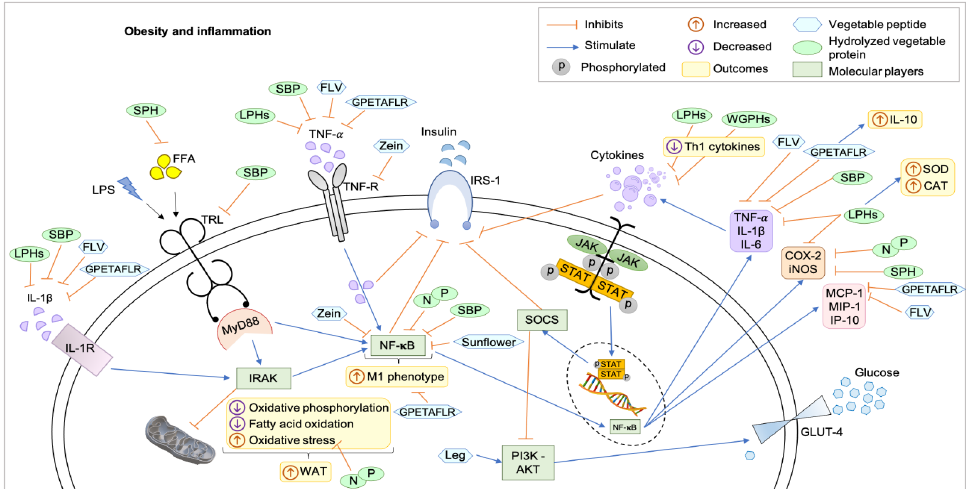
Figure 1. Mechanisms of action of hydrolyzed proteins and plant peptides on obesity and inflammation in a hypothetical eukaryotic cell. All hydrolyzed proteins and peptides acted to reduce inflammation through metabolic pathways that communicate and are responsible for the positive feedback cascade for the accumulation of more adipose tissue and subclinical inflammation, as well as some compounds acted by feeding detoxification and detoxification pathways. reduction of oxidative stress. CAT: catalase,